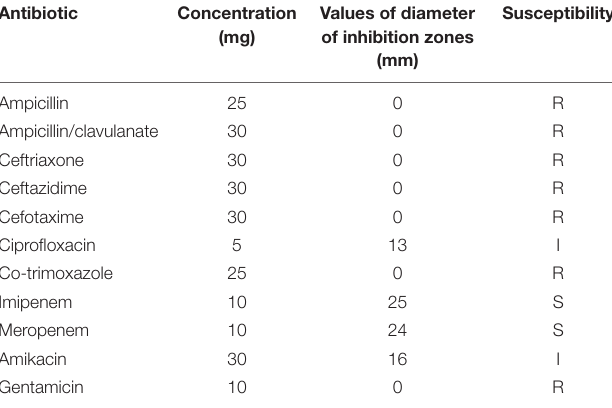
TABLE 1 | The susceptibility of K. pneumoniae to antibiotics. Antibiotic